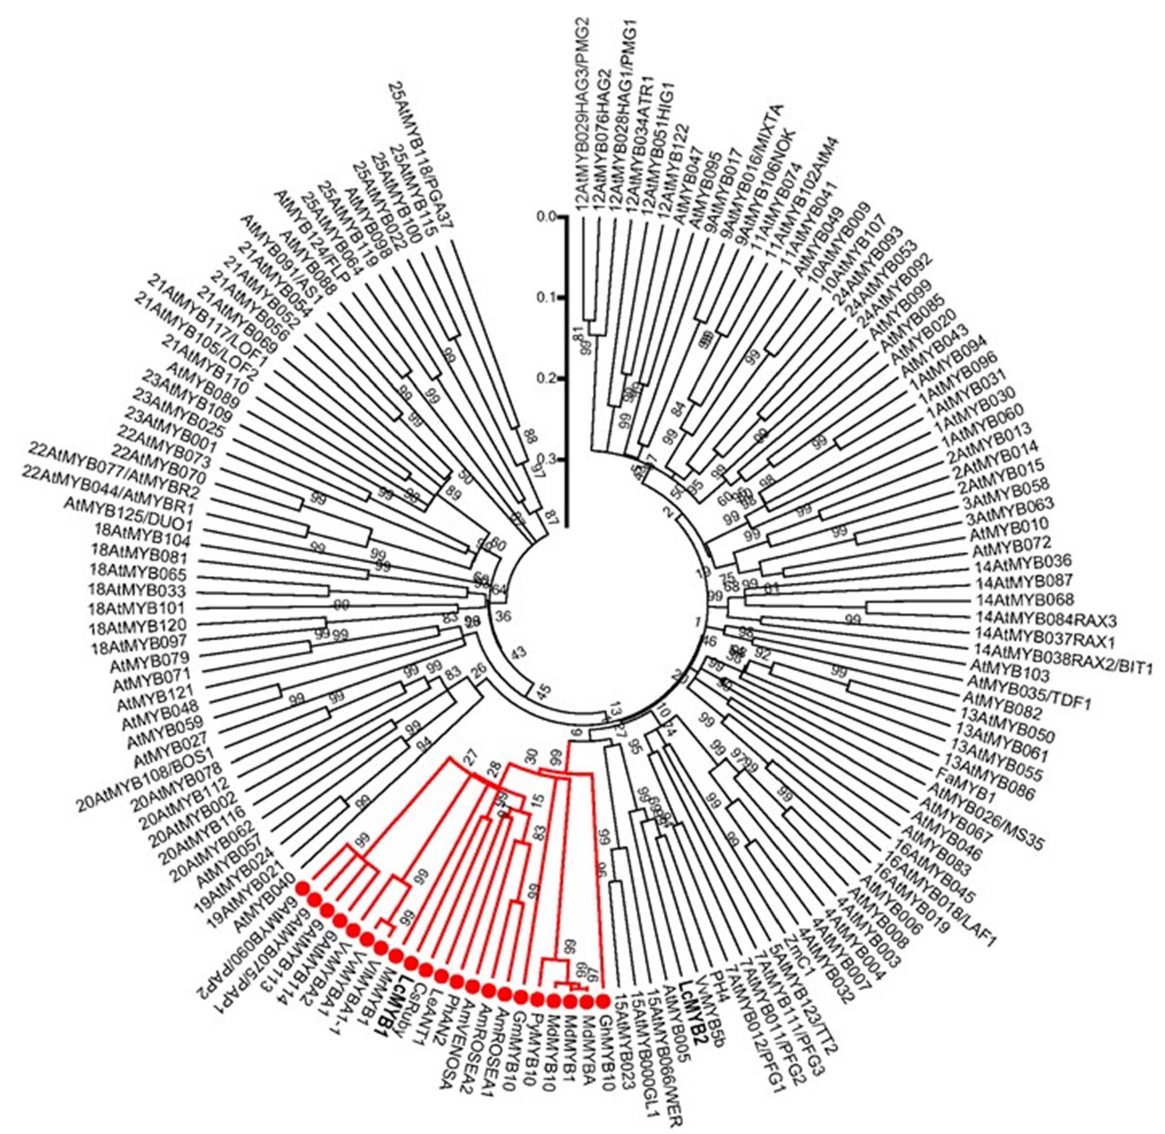
Figure 2. Phylogenetic relationships between Arabidopsis MYB transcription factors and anthocyanin-related MYBs in other species. LcMYB1 clusters next to CsRudy , within the anthocyanin subgroup 6 MYBs. The subgroup numbers were previously described [12]. The tree was constructed using MEGA 5, neighboring-joining phylogeny testing, and 1,000 bootstrap replicates. The accession numbers for the genes in the other species are provided in Figure